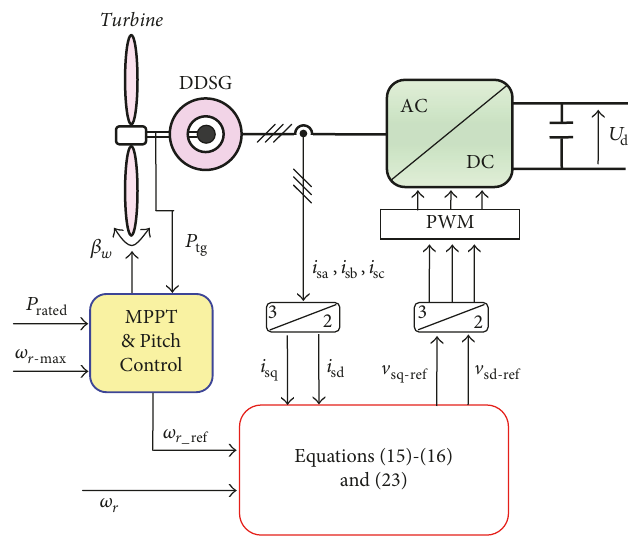
Figure 6: Control block diagram of MSR using backstepping